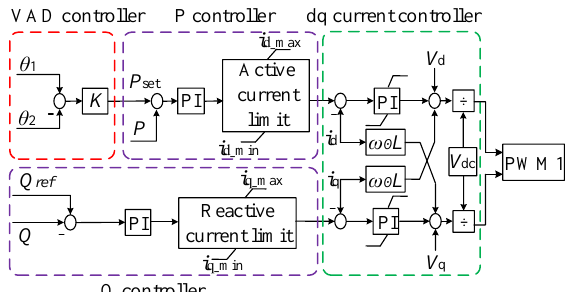
Fig. 2. Control diagram of the voltage angle droop controlled HVDC